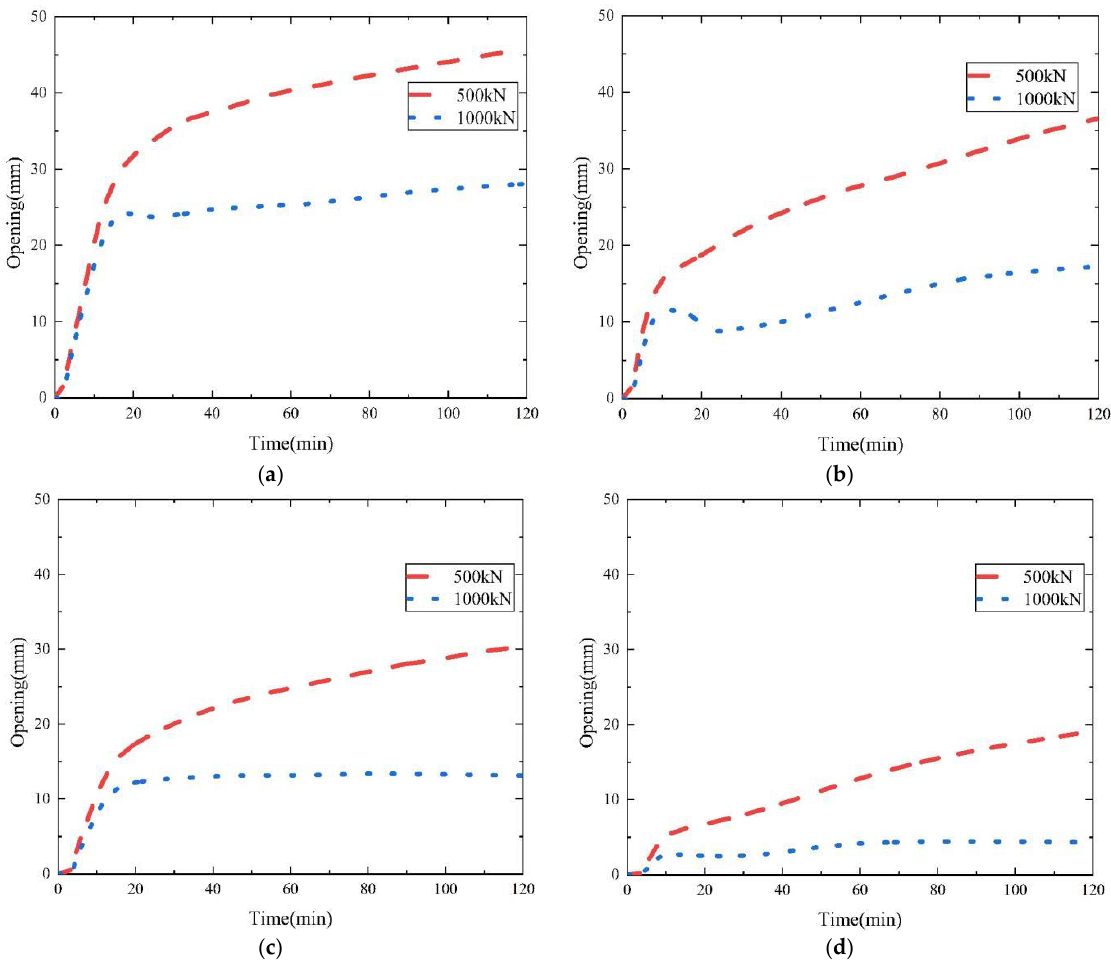
Figure 16. The opening gap fire time of the four joints with different initial axial forces. ( a ) MJ. ( b ) BMJ. ( c ) PJ. ( d ) BPJ.